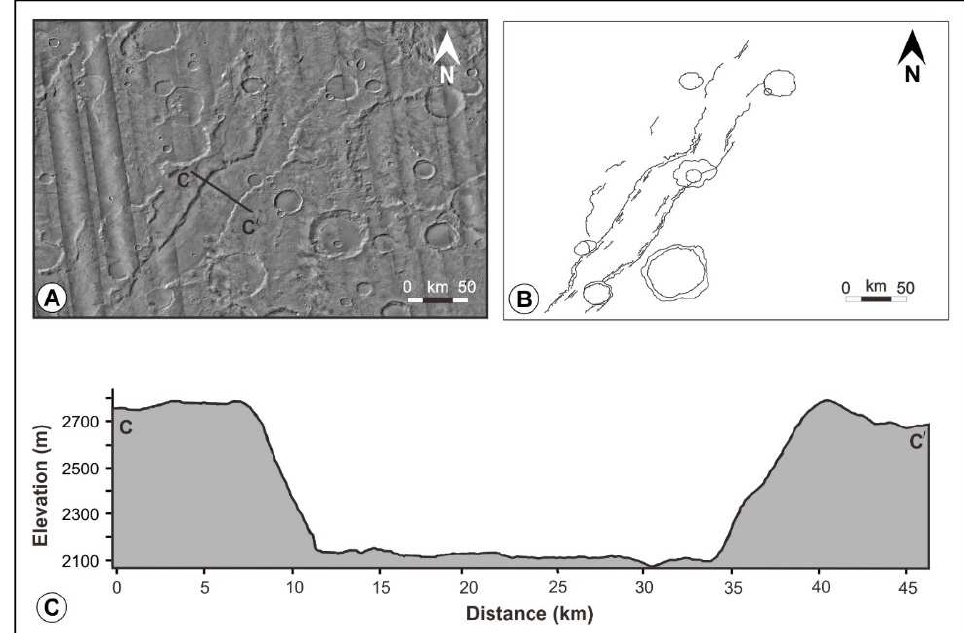
Figure 3. ( A ) WH extensional structures shown on CTX images. High-resolution view of a 35 km wide WH graben in Noachis Terra region. ( B ) Traces of structures drawn over Figure A. ( C ) the topographic profile section C–C′ shows that the graben in this set of extensional structures have similar elevations implying both faults on either side of the graben have received equal importance during extension.